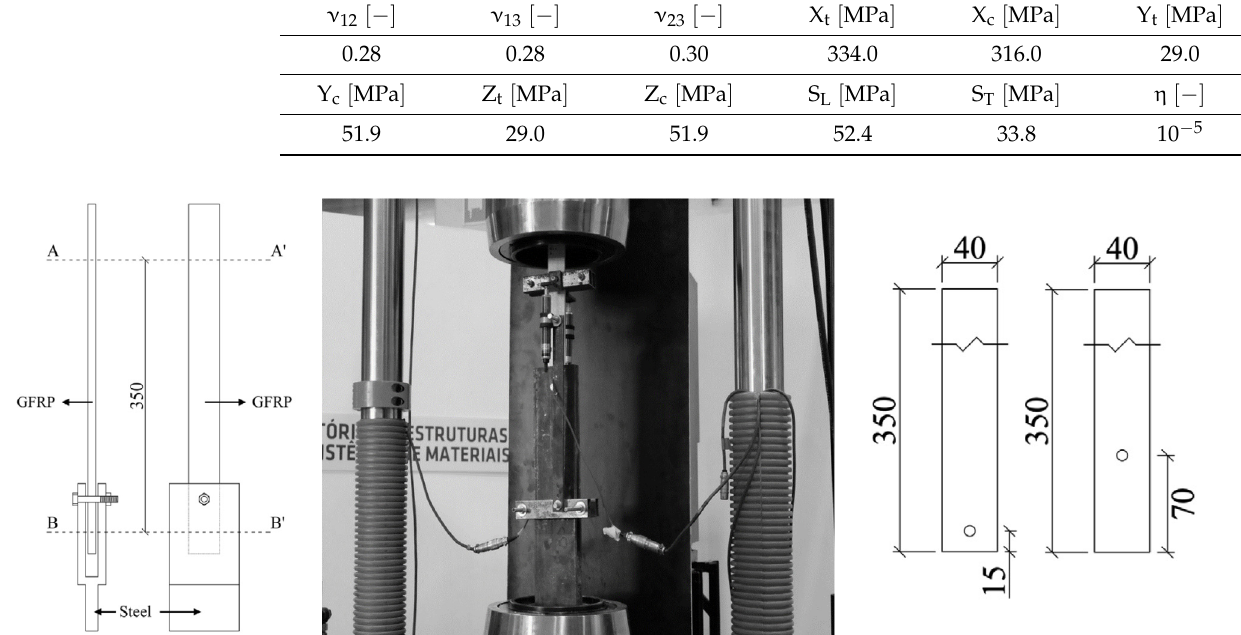
Figure 15. Test setup for the loading conditions and impose displacement for the double-lap test, and used bolt edge distance (cover) for the circular opening [57].